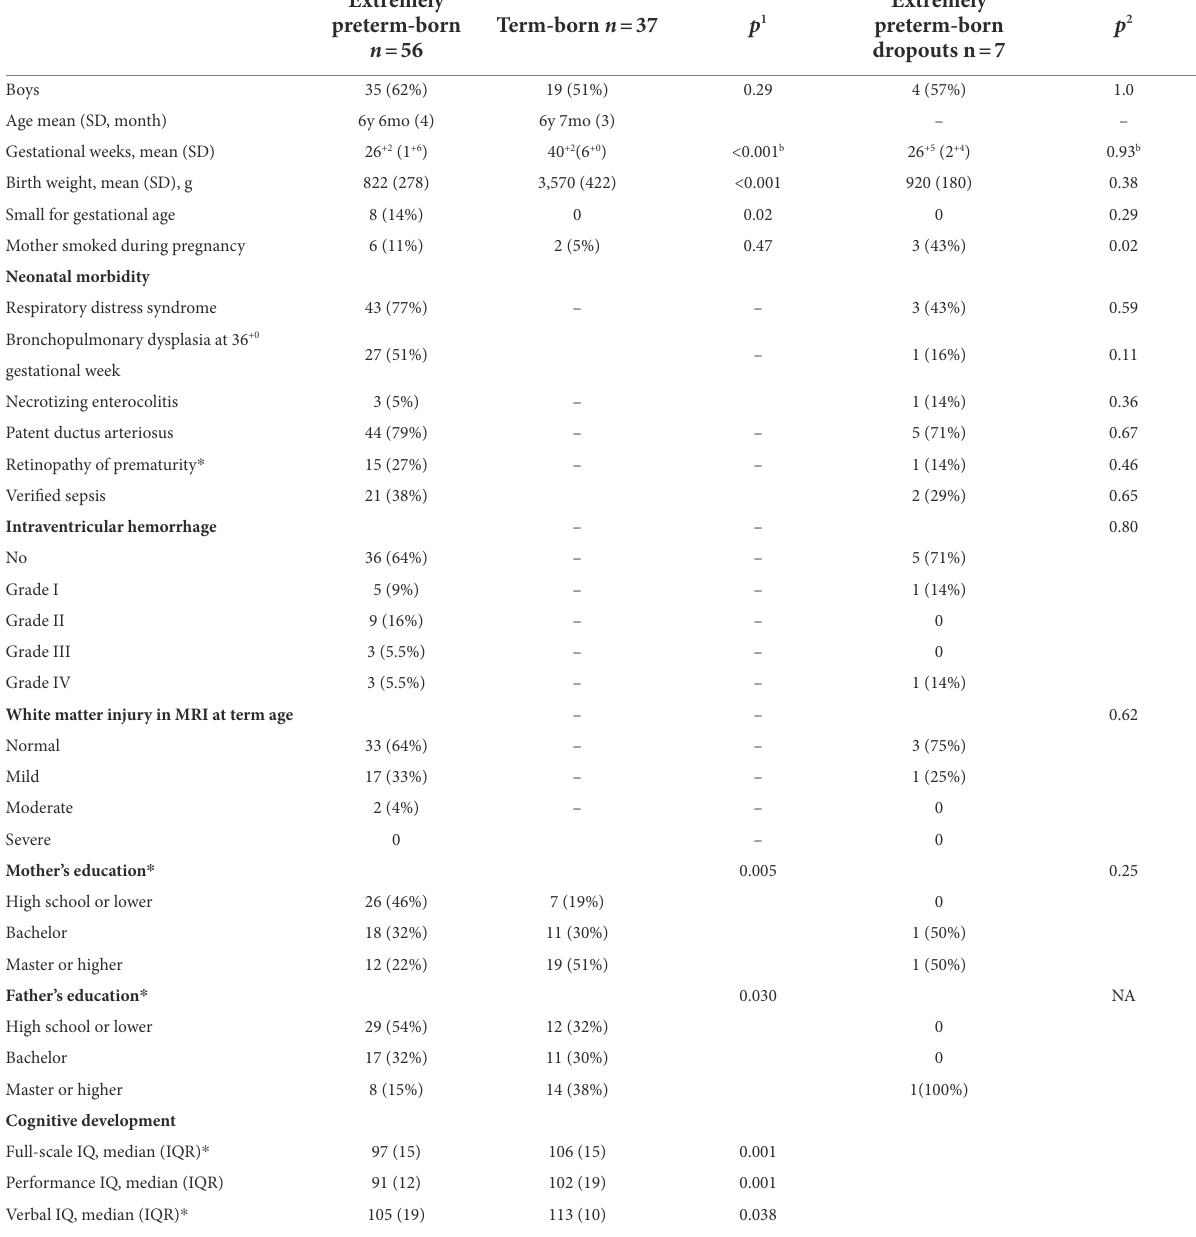
TABLE 1 Characteristics of the extremely preterm and term-born participants and extremely preterm-born dropouts. Extremely